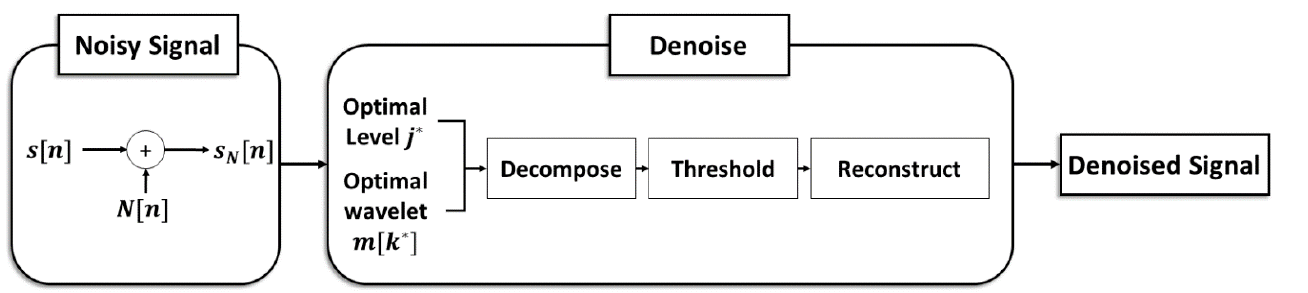
Figure 4. The block diagram of the denoising method.